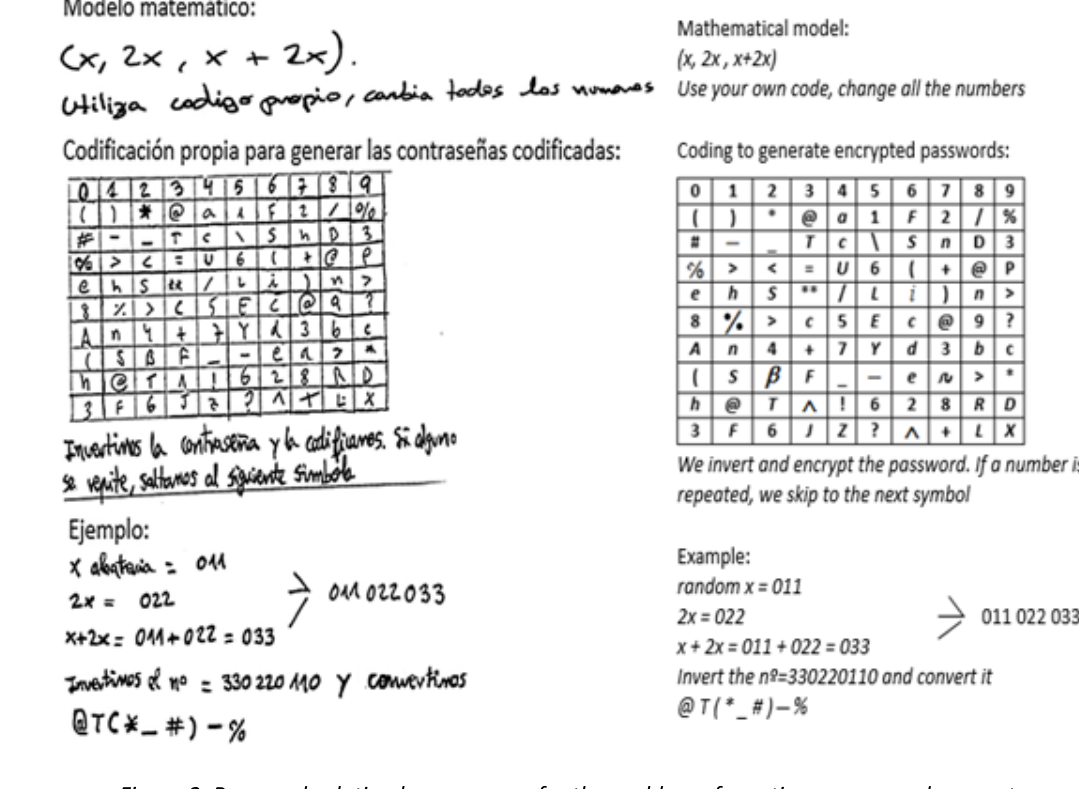
Figure 2. Proposed solution by one group for the problem of creating a password generator